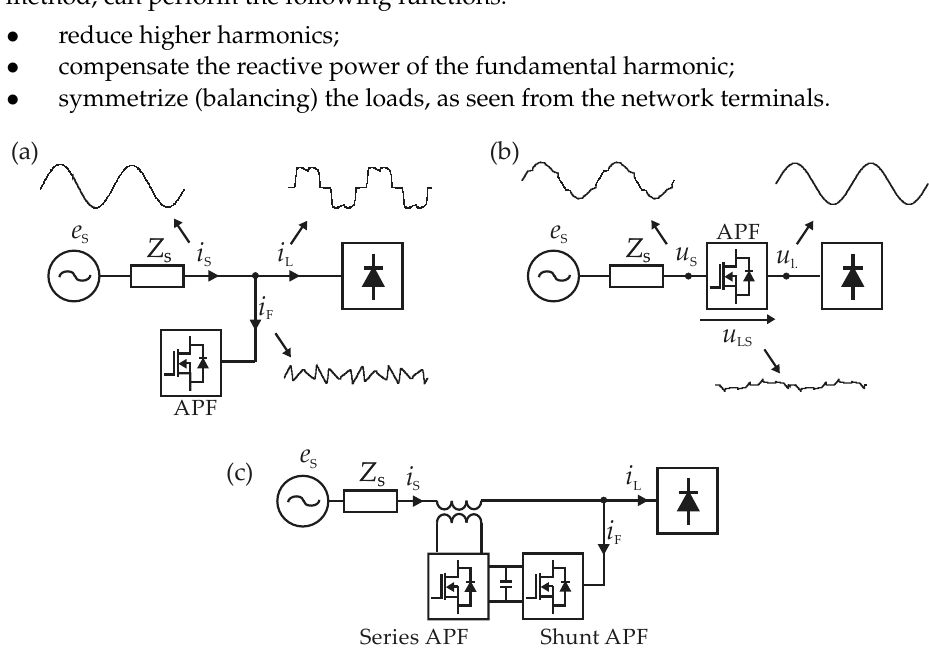
Figure 3. Diagrams illustrating the principle of operation of active power filters: ( a ) shunt circuit, ( b ) series circuit, ( c ) unified power quality conditioner.